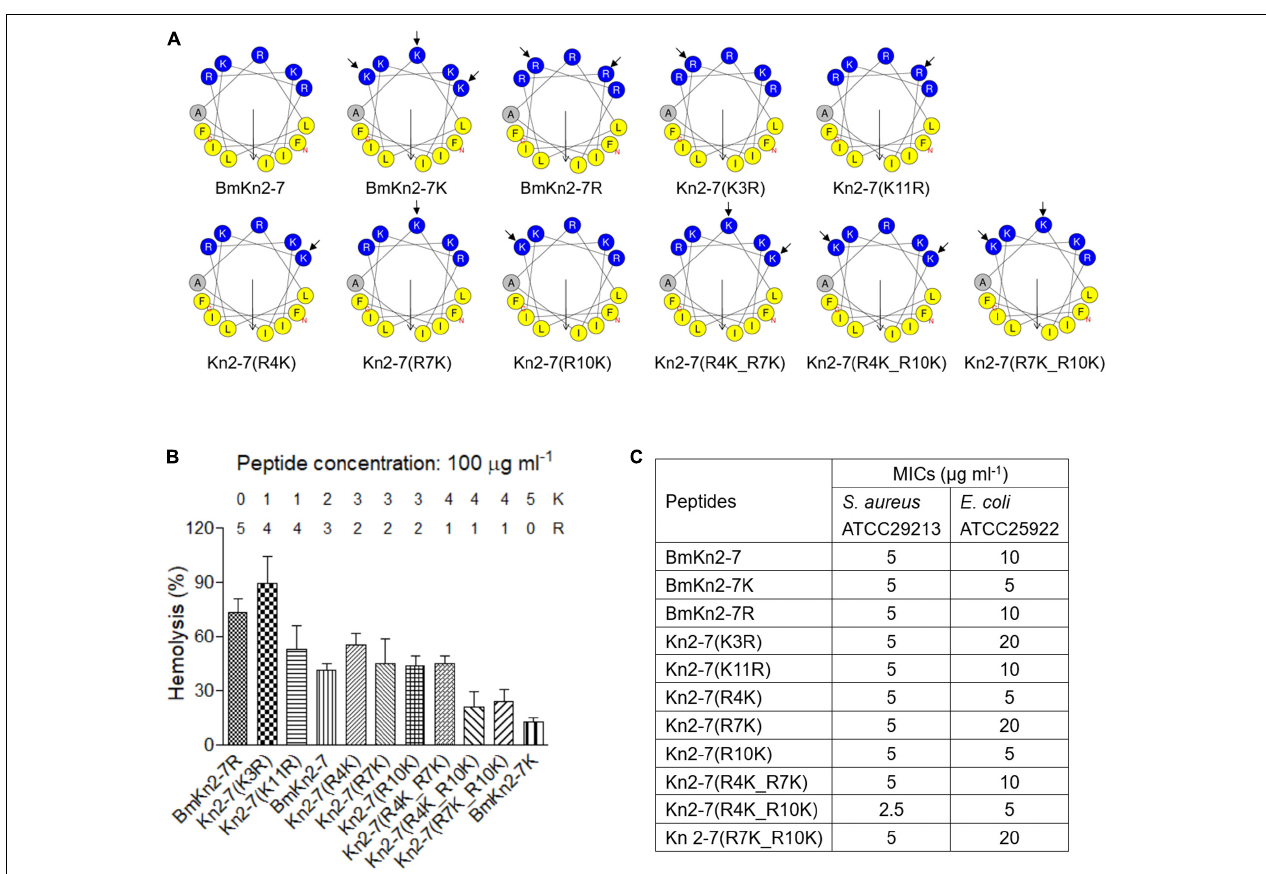
FIGURE 3 | Design, hemolytic and antimicrobial activity analyses of BmKn2-7 analogs. (A) Helical-wheel projections of BmKn2-7, BmKn2-7K, BmKn2-7R and the other designed peptides. (B) The percent hRBC hemolysis at 100 µ g ml - 1 was determined for BmKn2-7 and the designed peptides, and the numbers of Arg and Lys residues of each peptide were shown. (C) The antimicrobial activity (MIC in µ g ml - 1 ) was determined against S. aureus ATCC29213 and E. coli ATCC25922. All experiments were repeated at least three times. were determined to be 41.0% and 12.2%, respectively ( Figure 3B